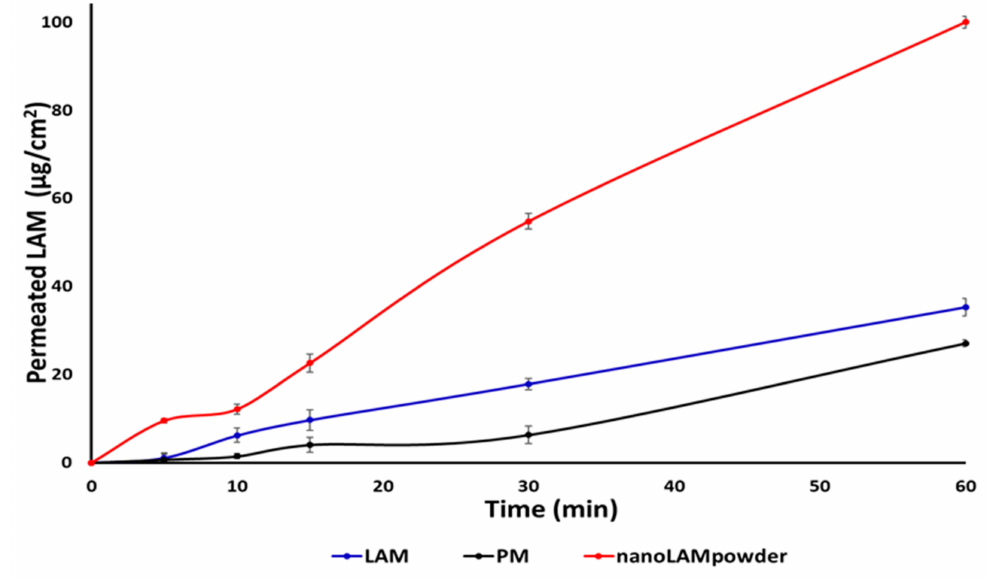
Figure 5. In vitro permeability study of the